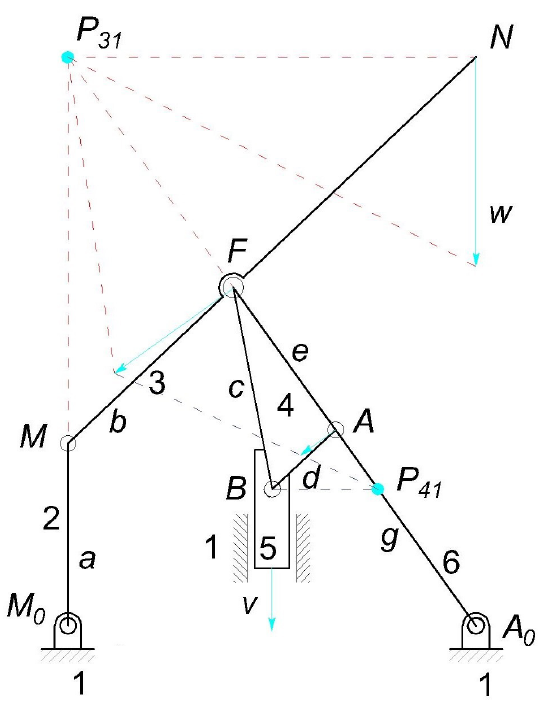
Figure 7. A view of the neutral configuration with the adopted